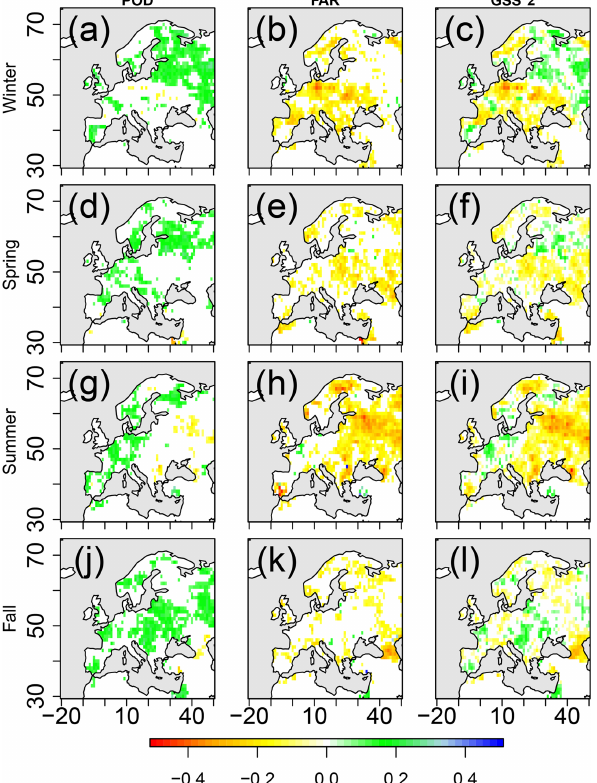
Figure 3. POD (a, d, g, j) , FAR ( b, e, h, k ; with reverse colours) and GSS (c, f, i, l) scores of droughts prediction calculated using the reference forecast. The scores are calculated for (from top to bottom) winter (DJF, a–c ), spring (MAM, d–f ), summer (JJA, g–i ) and autumn (SON, j–l ).